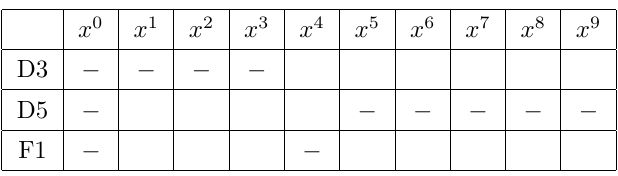
Table 3 . Brane set-up associated to the D3-D5-F1 brane configuration that describes Wilson loops in the antisymmetric representation of U ( N ) in 4d N = 4